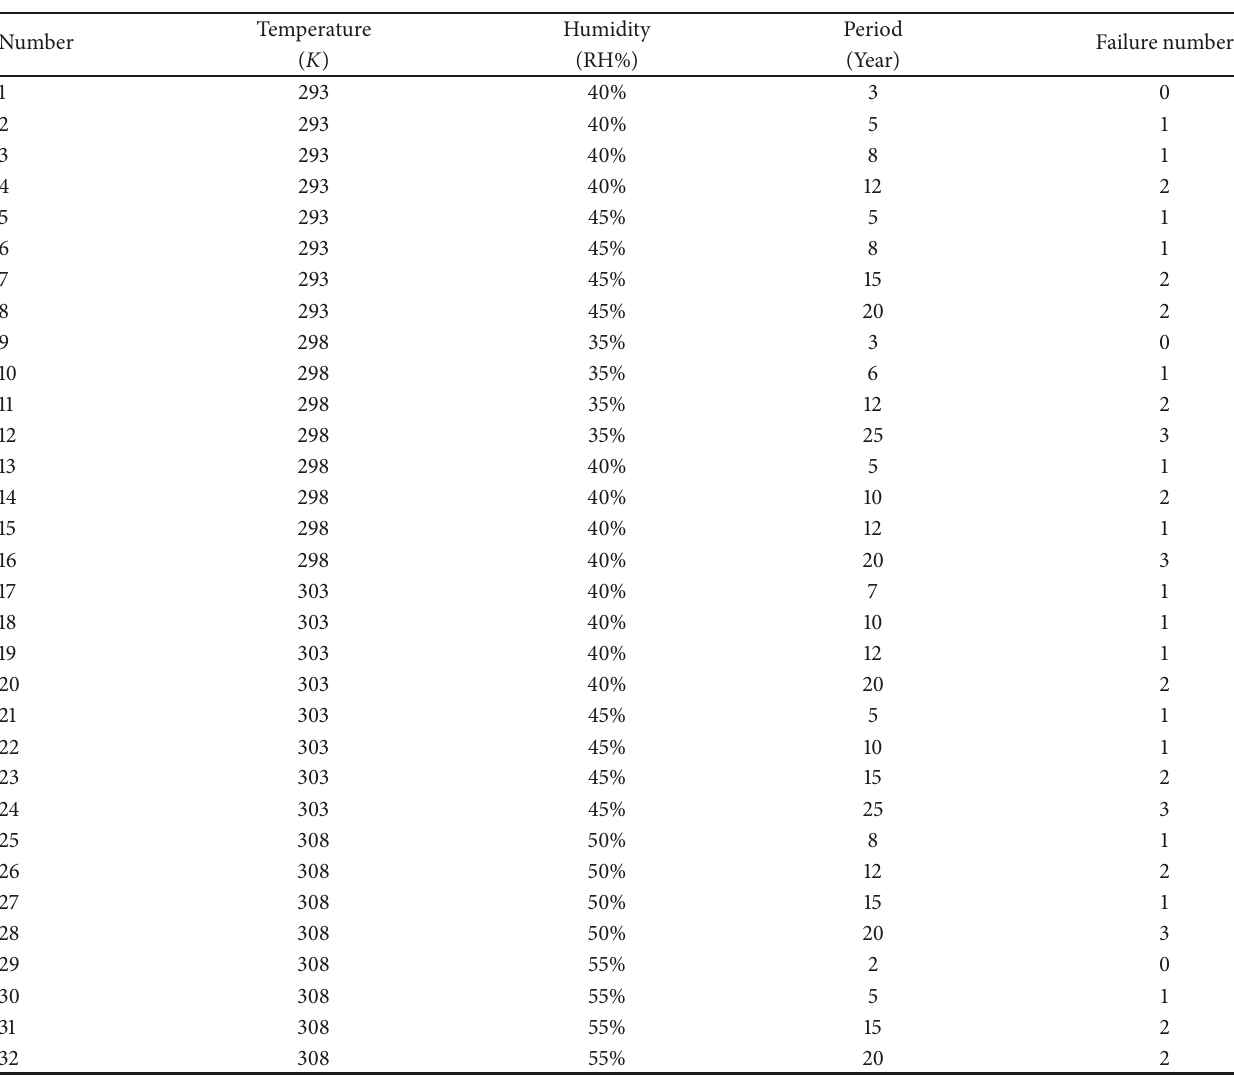
Table 1: Raw data